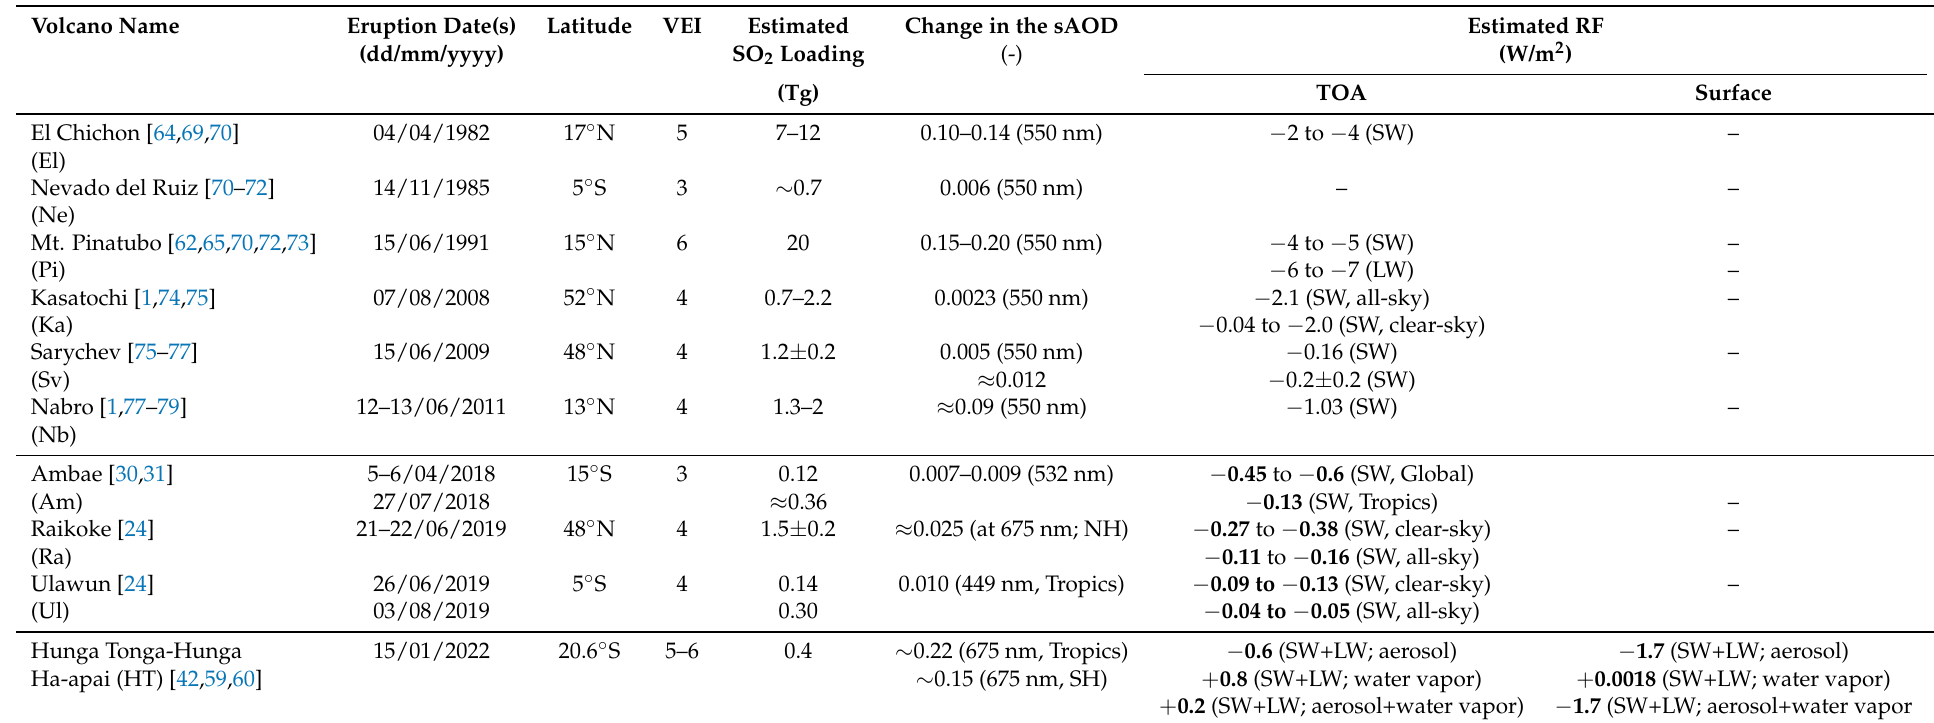
Table 2. List of significant volcanic eruptions with estimated aerosol loading and radiative forcing (RF), as reported in various published studies. The VEI values were obtained from https://www.usgs.gov/programs/VHP (accessed on 28 June 2022). RF values in bold font denote the estimates from offline/hybrid radiative transfer modeling using direct inputs from satellite observations. RF values (in normal font) are estimates from 3D global chemical transport models (online). SW and LW denote the shortwave and longwave spectral regions,